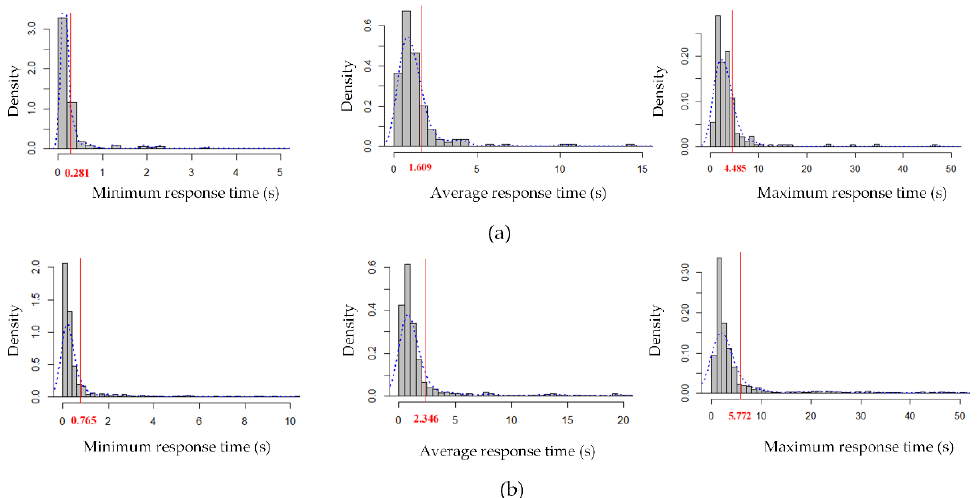
Figure 13. Unit area histograms for the minimum, average and maximum response times of ( a ) GetCapabilities operations and ( b ) GetMap operations for selected WMSs; the vertical red line in each chart divides the WMSs into 80% and 20% proportions, respectively. The density, calculated as frequency /( total_frequency * bin_width ), shows the proportions of WMSs for per unit of response time.